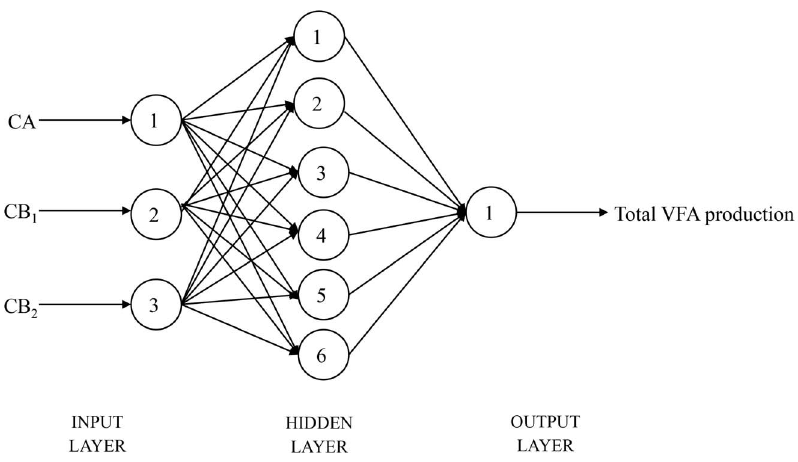
Fig. 1. The basic structure of back propagation neural network for total VFA